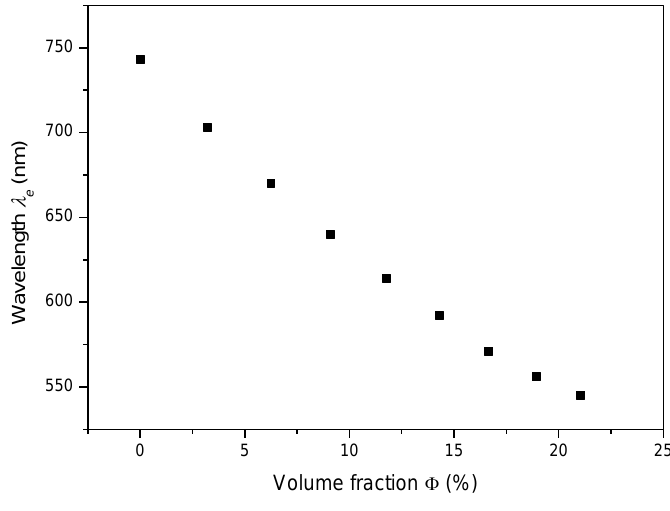
Figure 5. Measured dependence of equalization wavelength  the binary